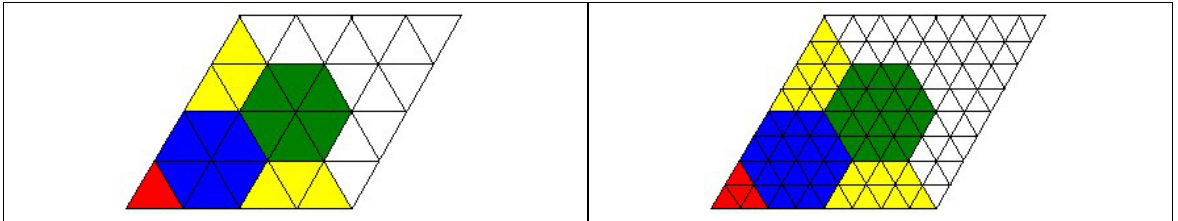
Figure 2. Rectangular Triangular-Z Mesh Subdivision